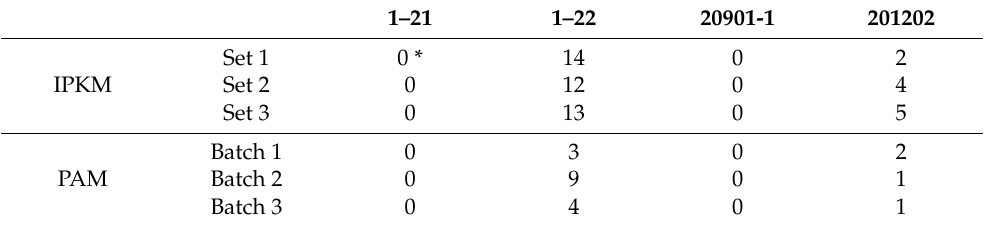
Table 3. Comparison of the reproducibility of IPKM versus PAM cells for virus isolation using 2% sausage homogenates (Lot No.2).